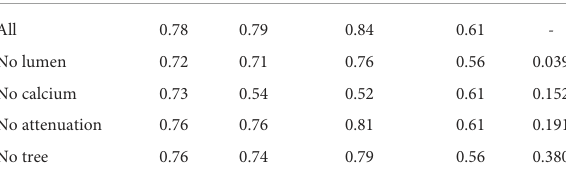
TABLE 6 Contribution of individual characteristics. Characteristics AUC Accuracy Sensitivity